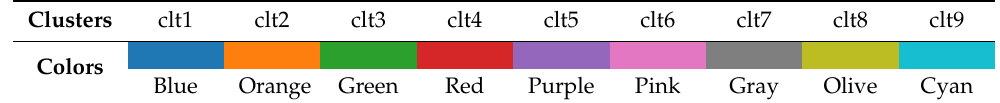
Table 3. Cluster color